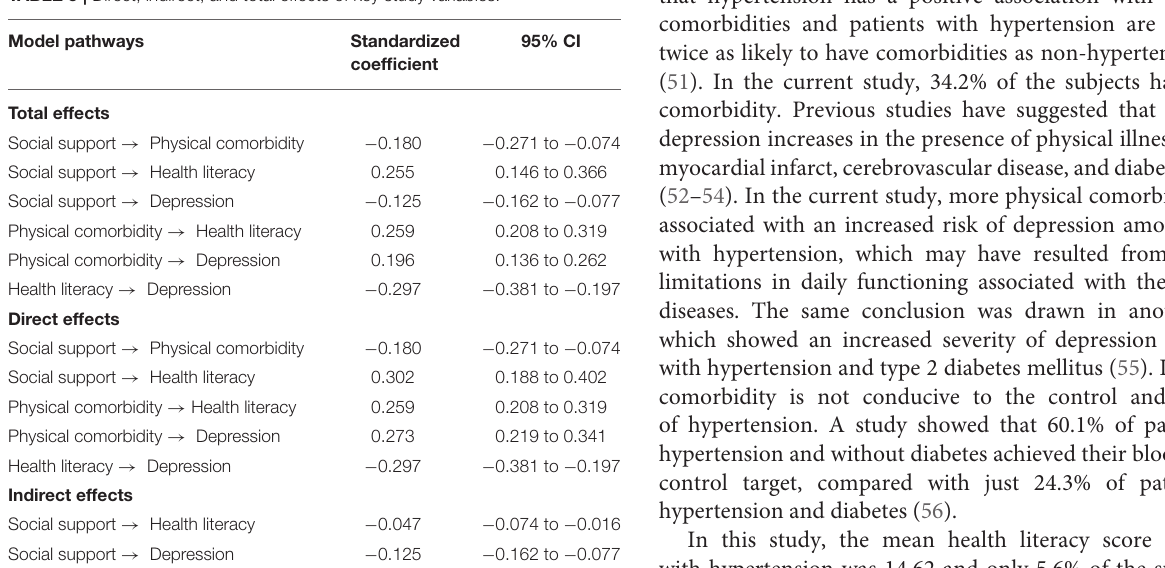
TABLE 5 | Direct, indirect, and total effects of key study variables.